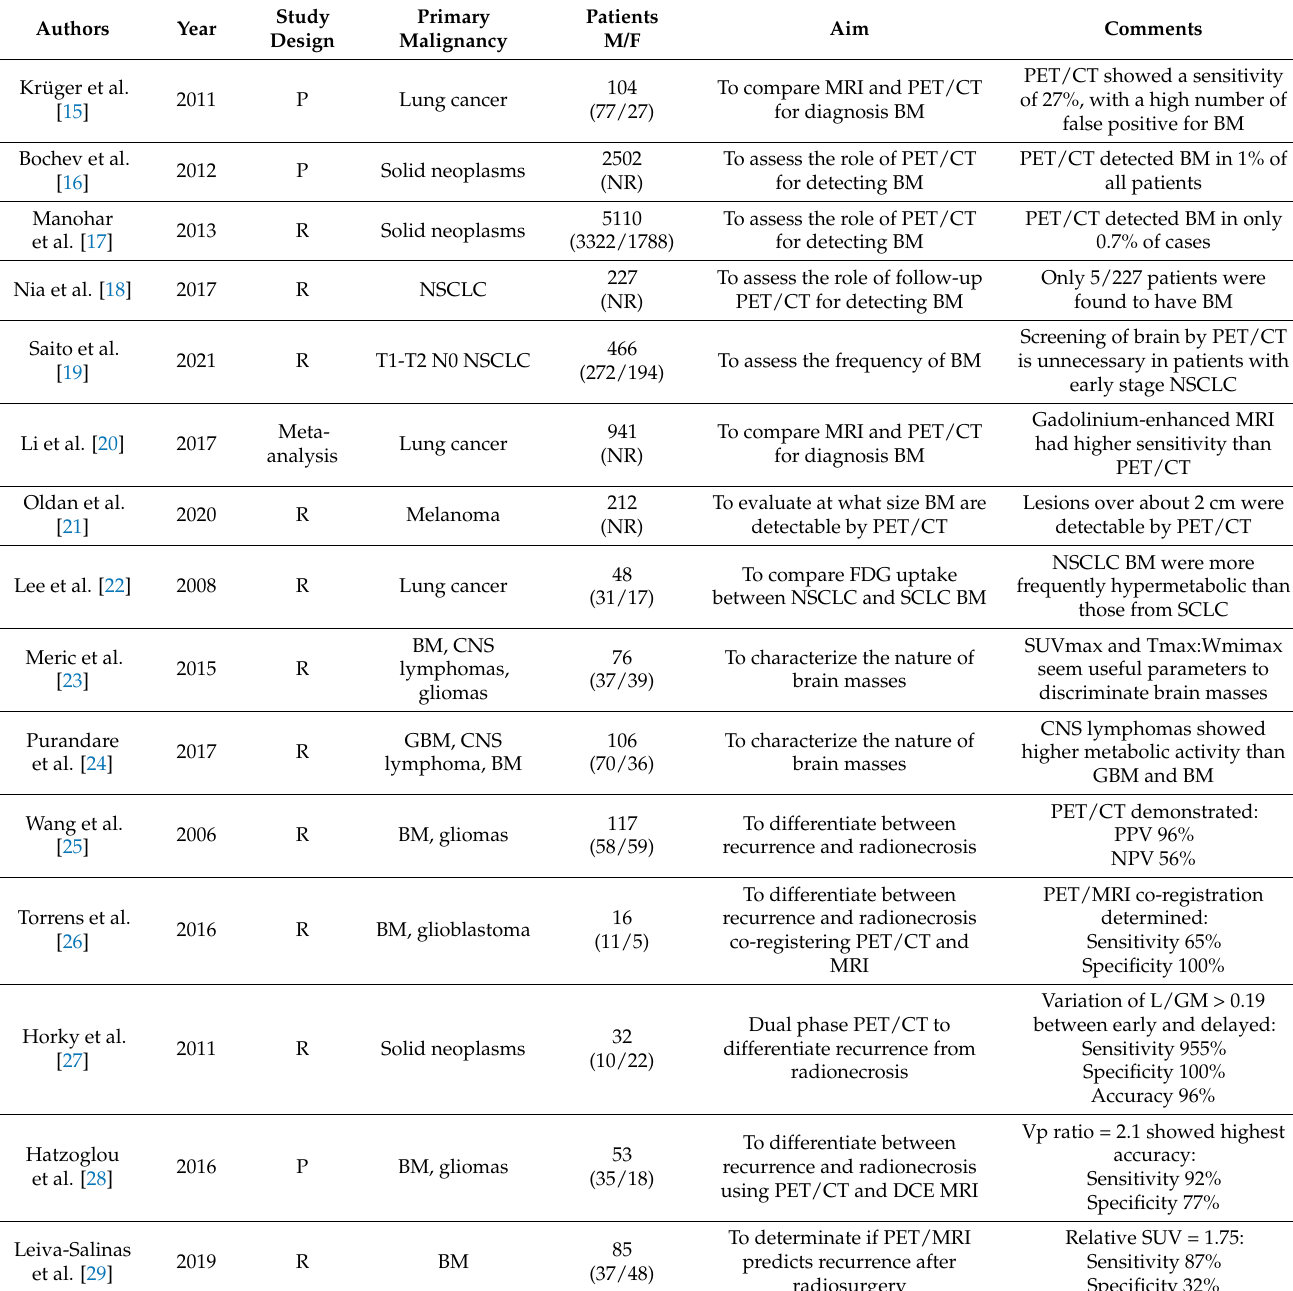
Table 1. Summary of general characteristics of studies with [ 18